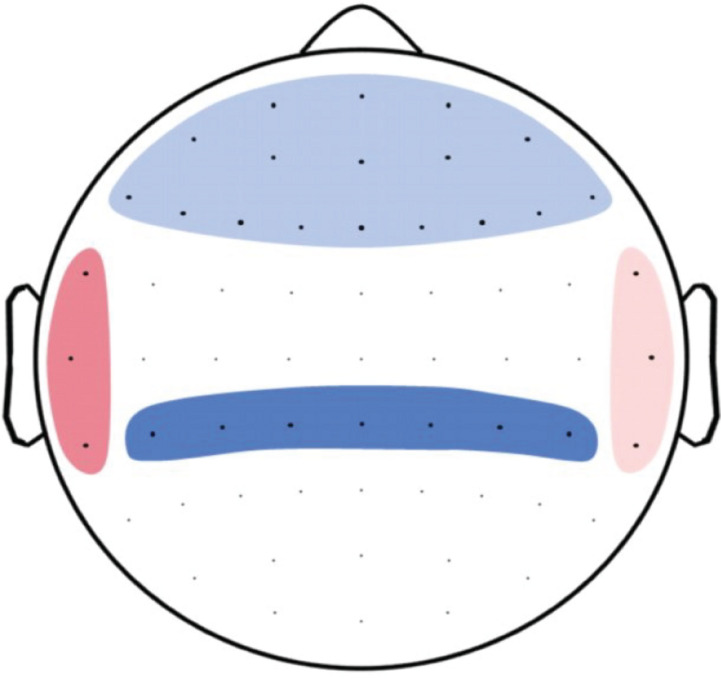
Topoplot of DFA clusters used to predict P300. Frontal cluster included the channels Fp1, Fpz, Fp2, AFz, AF3, AF7, AF4, AF8, Fz, F1-8, FCz, and FC1-6 (light blue). Temporal right cluster included channels TP8, T8, and FT8 (light red). Temporal left cluster included channels TP7, T7, and FT7 (dark red), and the inferior parietal cluster included channel CP1-5 and CPz (dark blue).